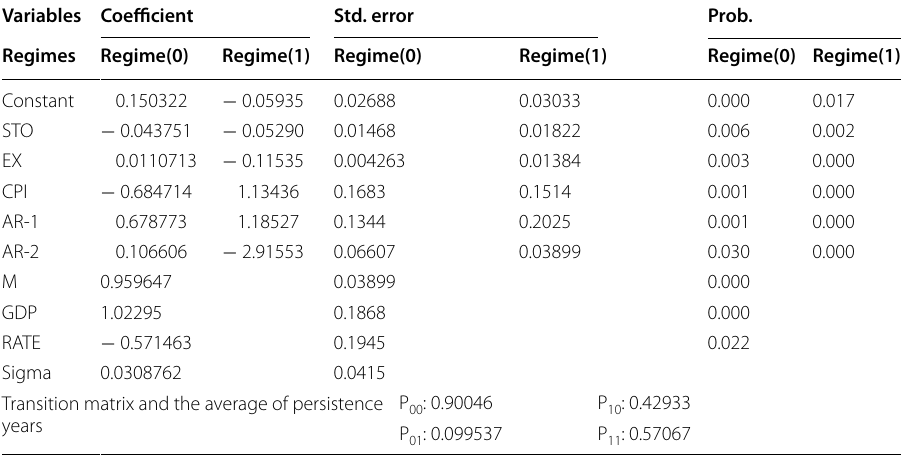
Table 6 The estimation results of equation DEP